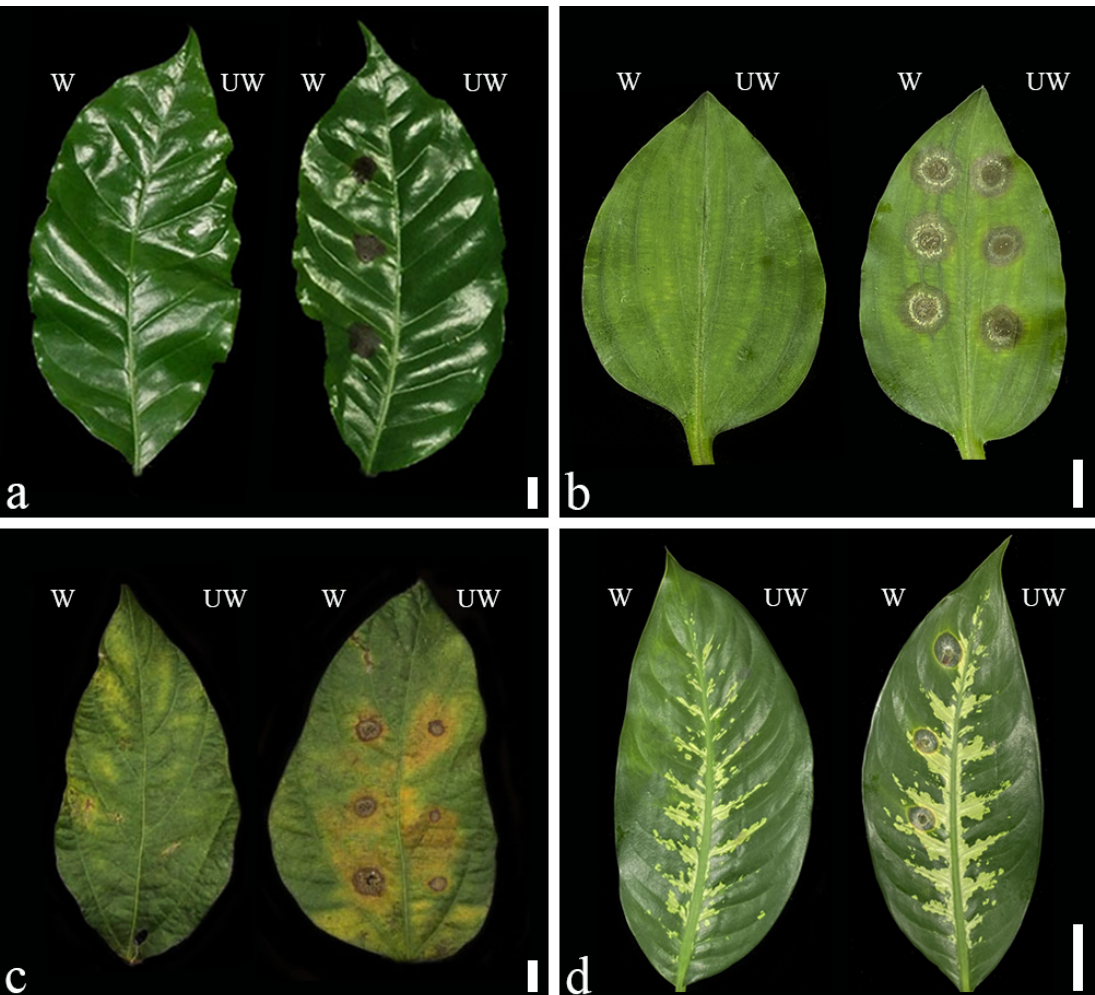
Figure 8 . Pathogenicity test ( a , b ) and cross pathogenicity ( c , d ); Control (left); ( a ) Paramyrothecium brevista on Coffea arabica ; ( b ) P . vignicola on Commelina benghalensis ; ( c ) P. vignicola on Glycine max ; ( d ) P. vignicola on Dieffenbachia seguine ; (w) wound and (uw) unwound. Scale bars: ( a – c ) = 1 cm; ( d ) = 6 cm.